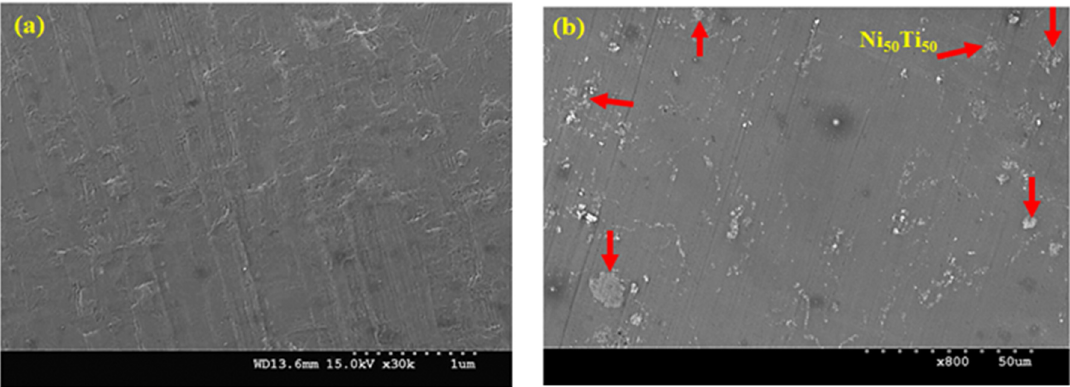
Figure 2. Representative SEM micrographs of: ( a ) pure Al and ( b ) Al-1.5NiTi nanocomposite.